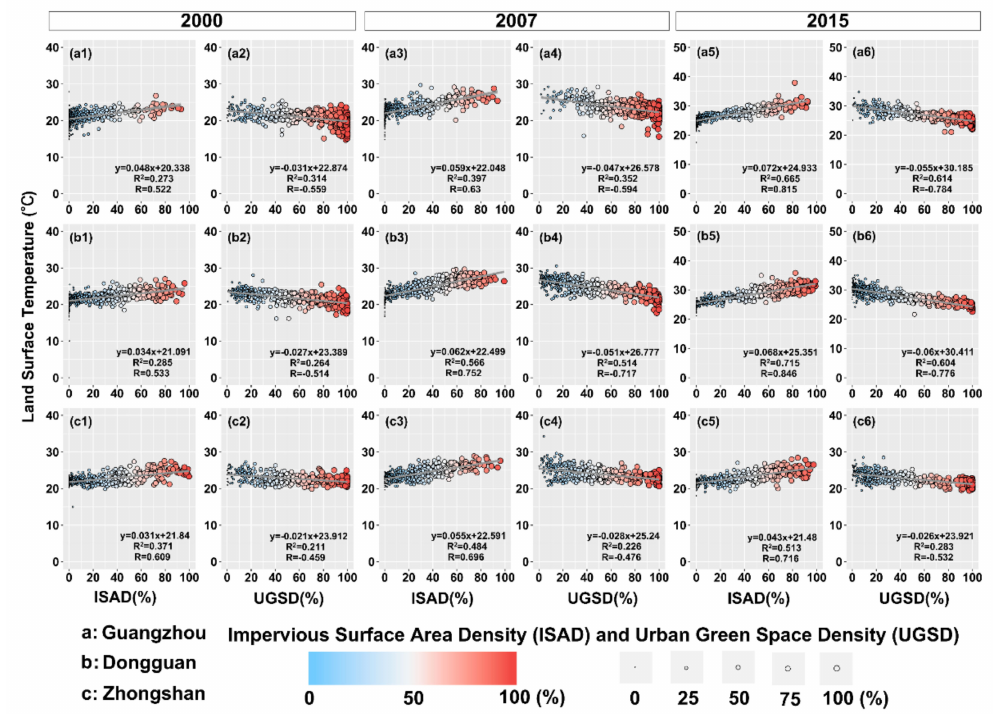
Figure 9. The relationship between the ISAD, UGSD and the LST across Guangzhou, Dongguan and Zhongshan from 2000 to 2015. Different colors and the size of bubbles denote the magnitude of the ISAD and